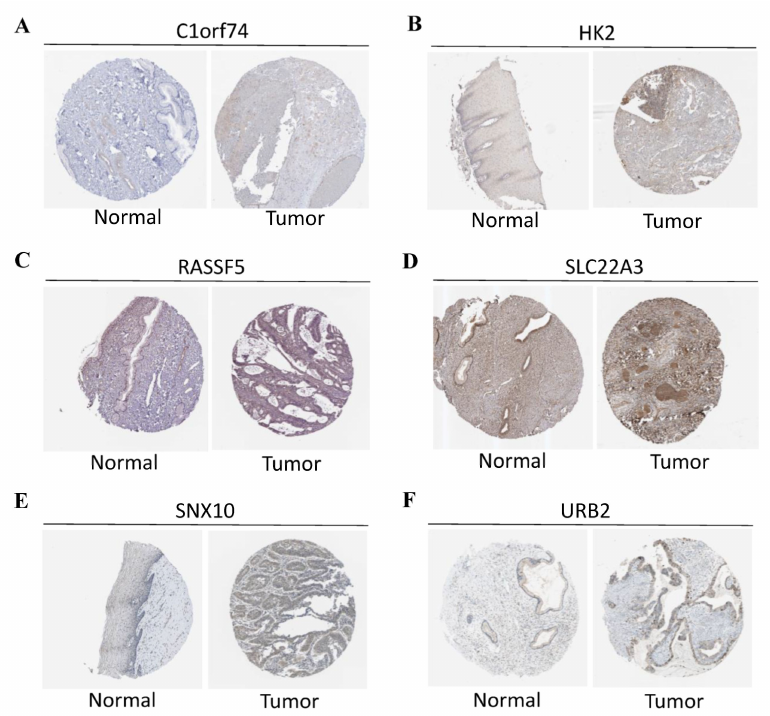
Figure 7. ( A ) Protein levels of C1orf74 in normal cervical tissues (Antibody: HAP028496, Staining: undetected, Quantity: none). Protein levels of C1orf74 in CESC tissues (Antibody: HAP028496, Staining: undetected, Quantity: <25%). ( B ) Protein levels of HK2 in normal cervical tissues (Antibody: HAP028587, Staining: low, Quantity: <25%). Protein levels of HK2 in CESC tissues (Antibody: HAP028587, Staining: low, Quantity: >75%). ( C ) Protein levels of RASSF5 in normal cervical tissues (Antibody: HPA070480, Staining: medium, Quantity: >75%). Protein levels of RASSF5 in CESC tissues (Antibody: HPA070480, Intensity: low, Quantity: <25%). ( D ) Protein levels of SLC22A3 in normal cervical tissues (Antibody: HPA029750, Intensity: medium, Quantity: >75%). Protein levels of SLC22A3 in CESC tissues (Antibody: HPA029750, Intensity: high, Quantity: >75%). ( E ) Protein